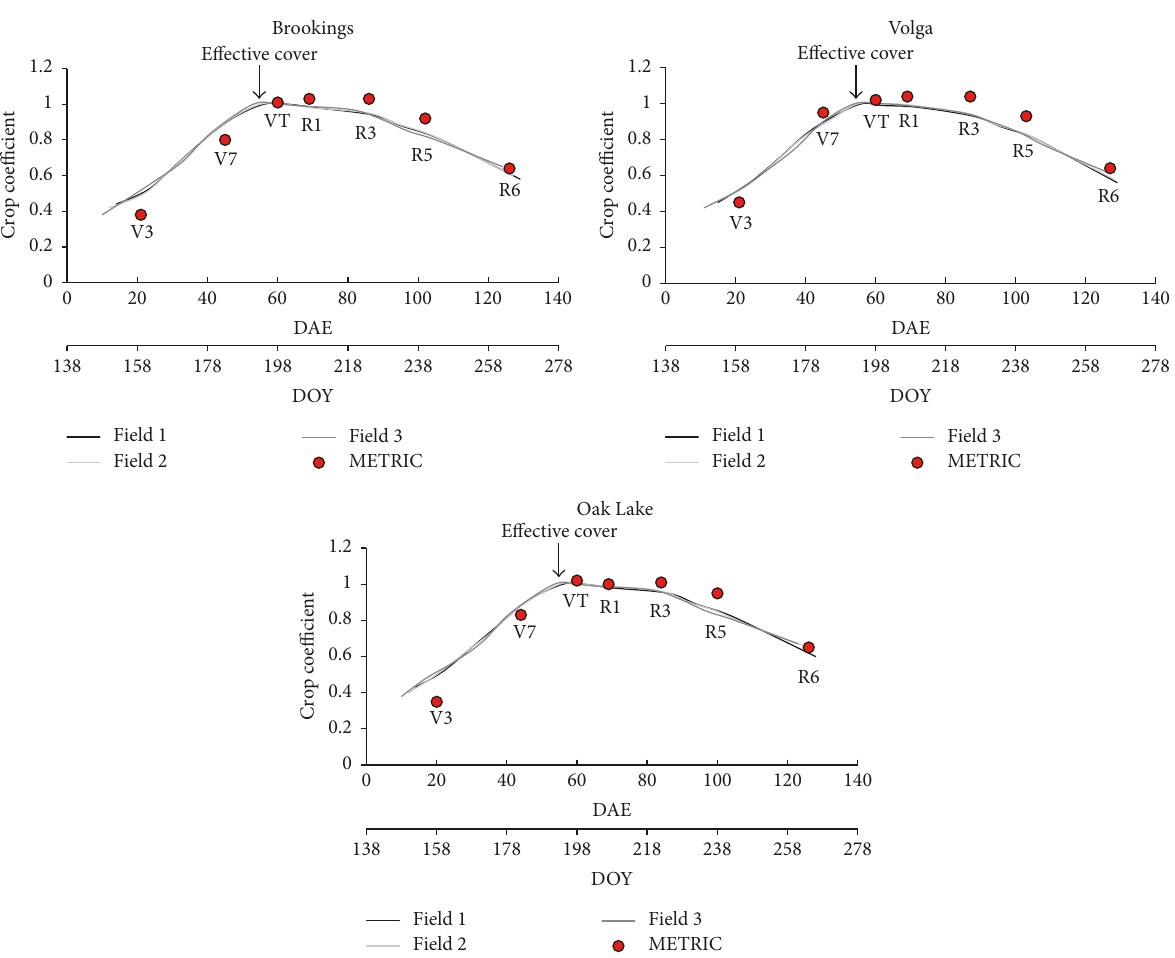
-atm values for three corn fields at three sites. a